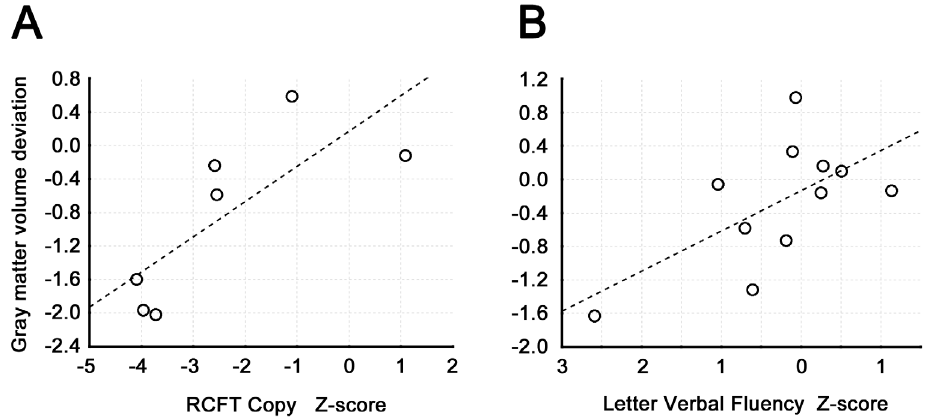
Figure 3. Association between component expressions and cognitive results. Fig. 3A shows correlation between the C1 component loadings and Rey-Osterrieth Complex Figure Test copy z-scores; Fig. 3B displays correlation between C2 component loadings and Letter Verbal Fluency Task z-scores.